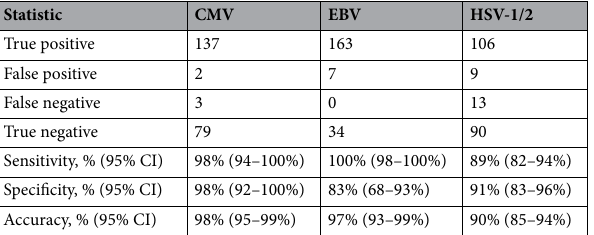
Table 2. Performance characteristics of VirScan PhIP-Seq method for serological detection of CMV, EBV and HSV compared to standard